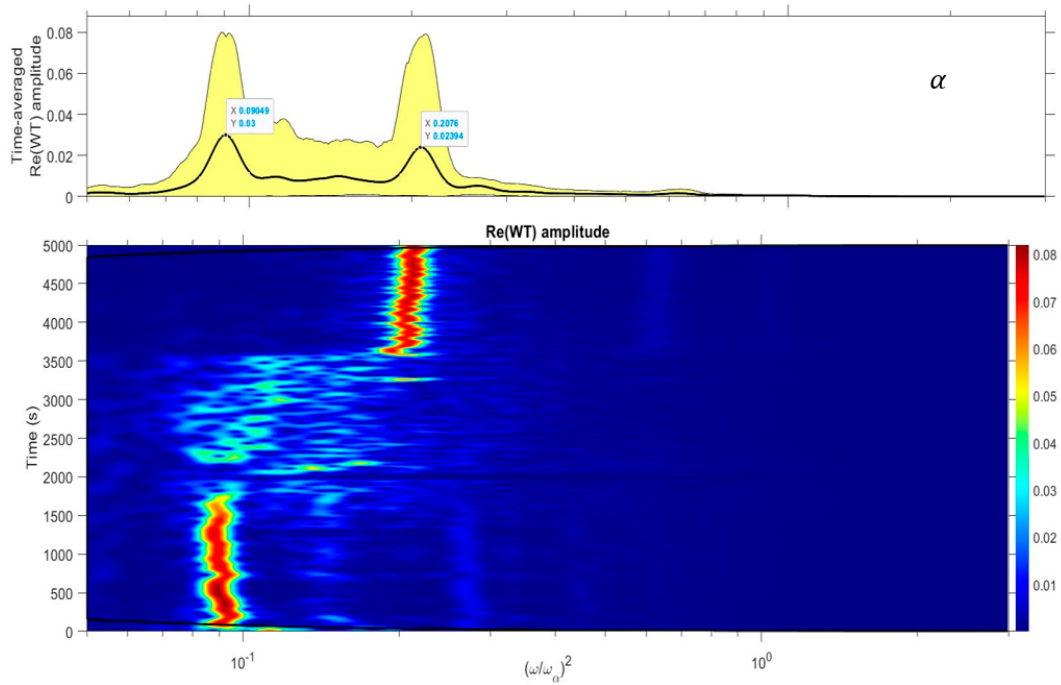
Figure 9. Time–frequency analysis of pitch displacement signal ( 𝑄 (cid:3042) = 9 ).